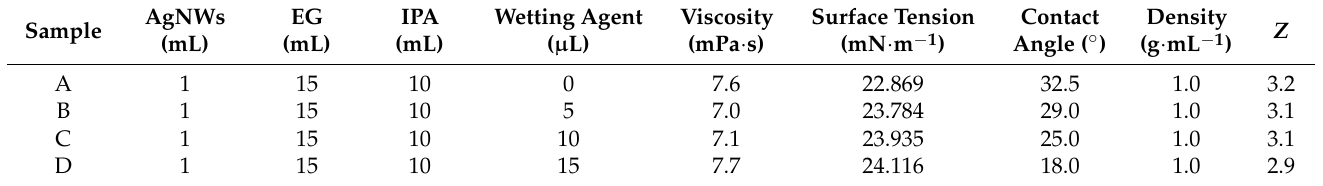
Table 1. Composition and performance of AgNWs